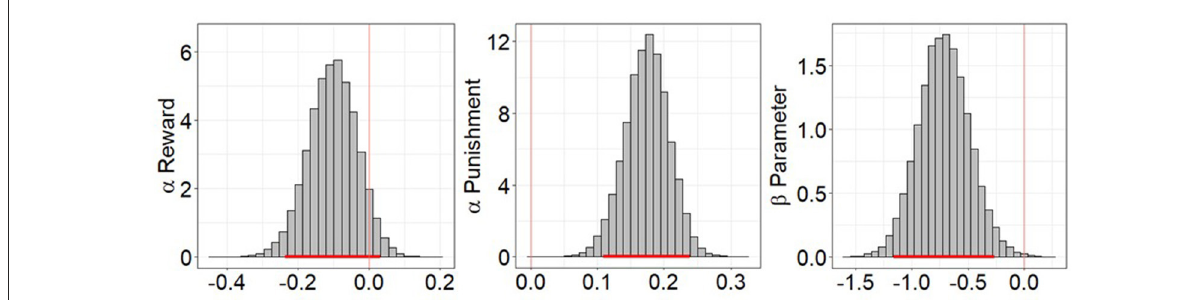
FIGURE3 Posterior distribution differences of reward-punishment model parameters between alcohol use disorder patients (AUDP) and healthy controls (HC). A parameter was considered to significantly differ between groups if the 95% highest density interval (HDI) did not overlap 0. Punishment learning rate was significantly higher in AUDP, but reward learning rate was only slightly lower in the AUDP than HC. AUDP also showed significantly lower inverse temperature than HC, suggesting reduced reward sensitivity. The red bar indicates the 95% HDI of the group